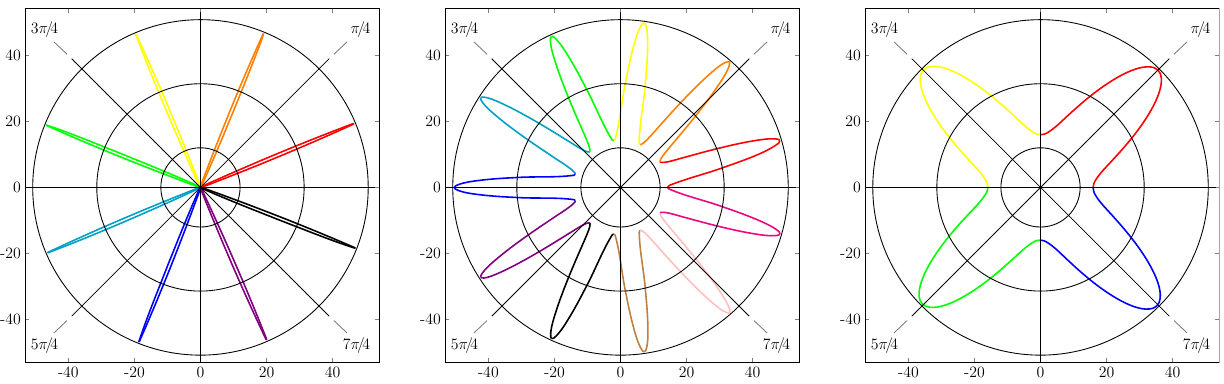
Δϕ = − 5 . 495 ≈ − 7 π/ 4. Middle panel: a = 10, J = 0 . 5, E = 0 . 966, r min = 14 . 31, r max = 50 . 26, Δϕ = − 5 . 71 ≈ − 20 π/ 11. Right panel: a = 10, J = 1 . 445, E = 0 . 9667, r min = 15 . 95, r max = 50 . 27, Δϕ = − 4 . 71 ≈ − 3 π/ 2